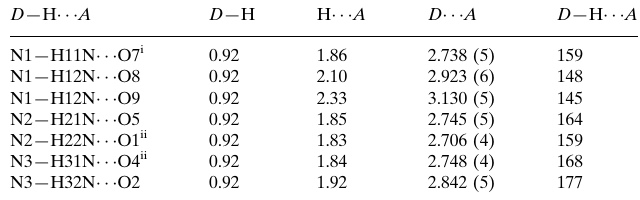
Hydrogen-bond geometry (A˚ , (cid:4)